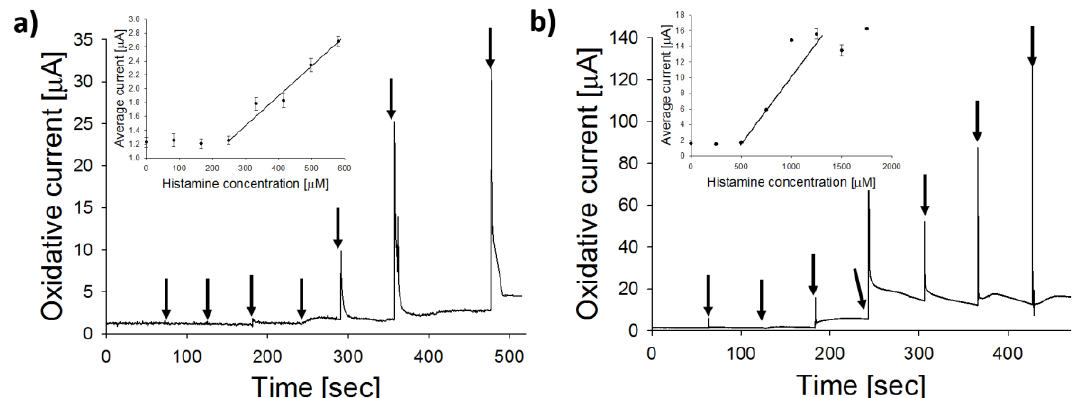
Figure 7. Representative DCPA curves showing histamine oxidation at constant potential of +500 mV. Calibration of ( a ) non-enzymatic electrode (sensitivity = 3.7 µA/mM, LOD = 261 µM); and ( b ) MFC-DAO nanobiosensor (sensitivity = 26.2 µA/mM, LOD = 62.9 µM). Arrows indicate addition of histamine into the electrochemical cell. Insets show the average output and linear operating range.